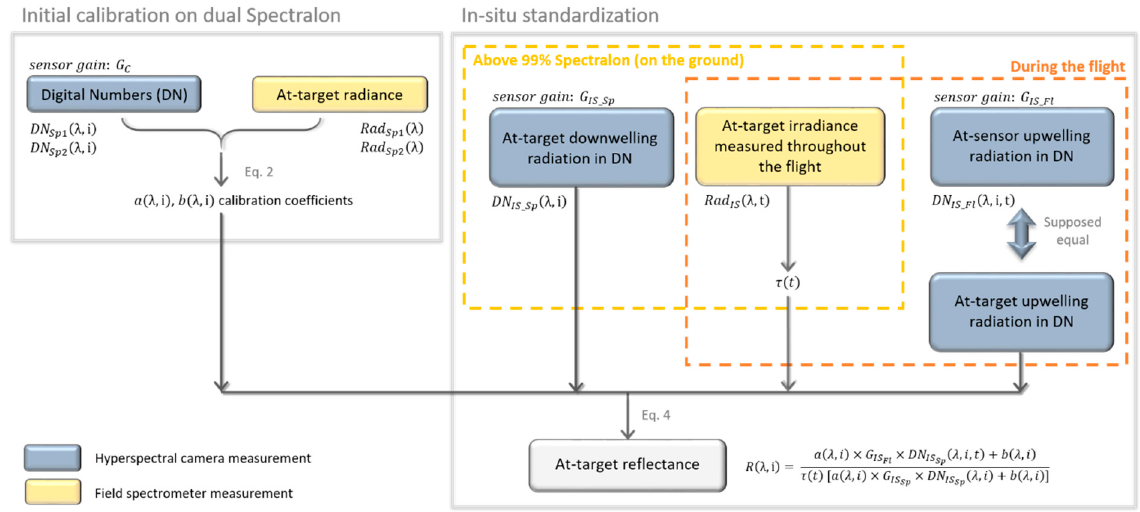
Figure 3. Processing steps performed for radiometric corrections (“ i ” is the index of the pixel along the sensor array, in the across-track spatial dimension).